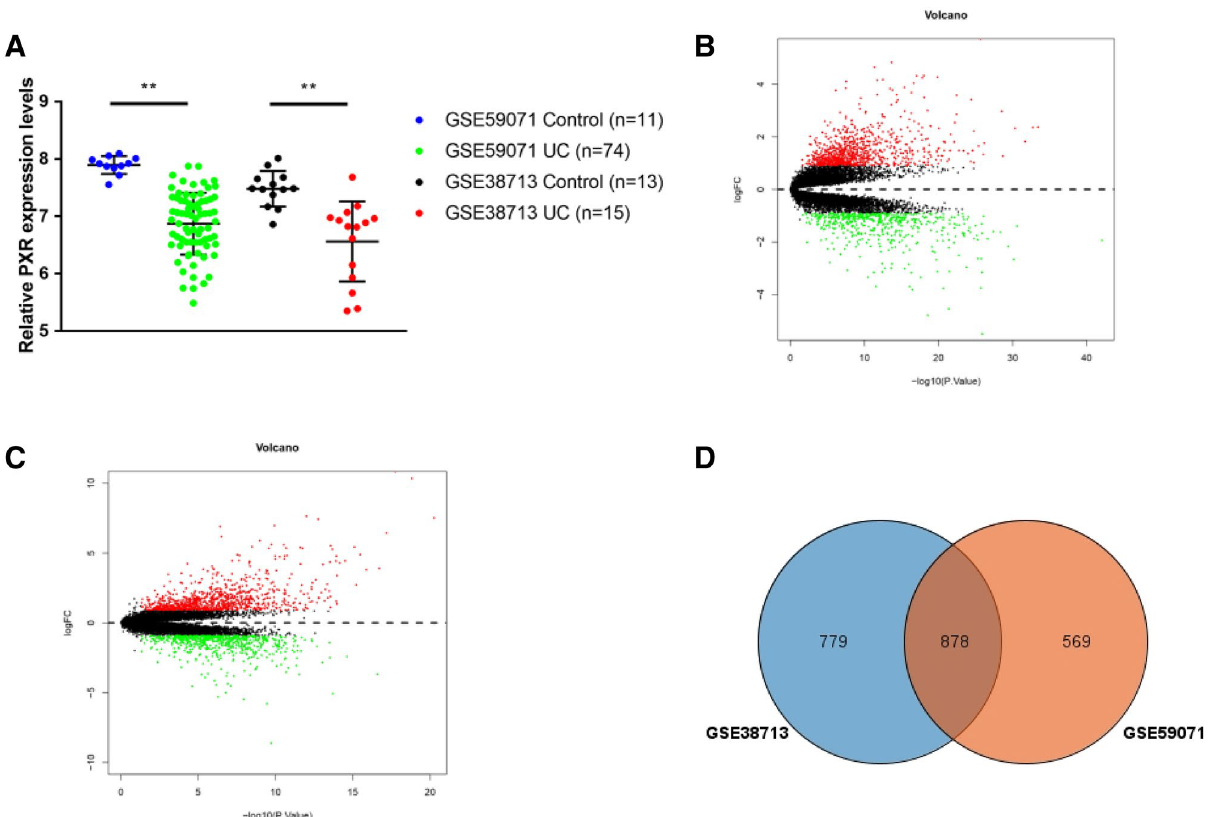
Figure 2. Identification the differentially expressed genes. ( A ) The expression level of PXR in GSE59071 and GSE38713 datasets. ** P < 0.01. ( B , C ) The volcanoplot of the DEGs between UC patients and control subjects in GSE59071 and GSE38713 datasets. ( D ) The Venn plot for selection of the overlapping DEGs in GSE59071 and GSE38713 datasets, overlapping DEGs =